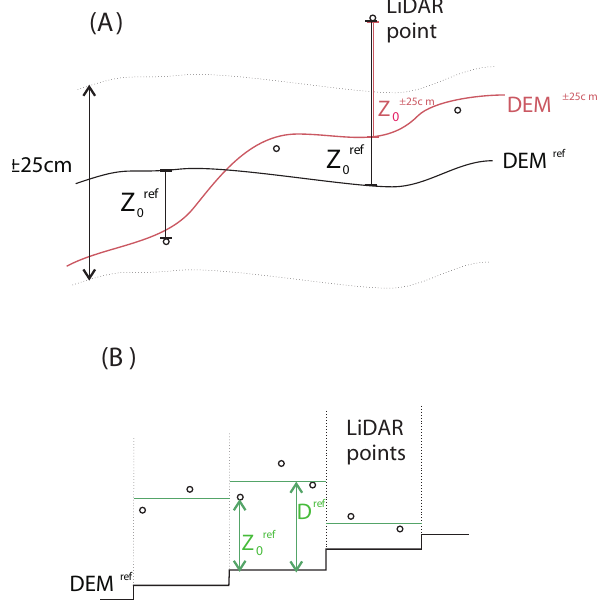
Fig. 2. (A) Selection criteria for the incorporation of a LiDAR point within the topographic or roughness parameterisation procedure. (B) Cell roughness calculation of averaged roughness height (D) for a representation scale.